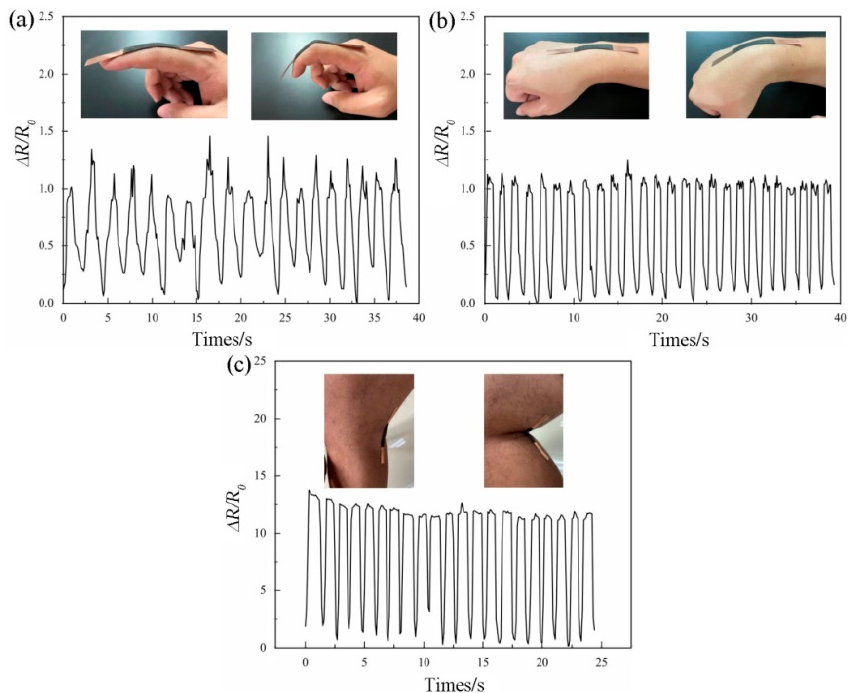
Figure 8. Monitoring of the motion of the human body with the functional flexible sensor. ( a ) Monitoring of the lateral flexion and extension of fingers, ( b ) monitoring of the lateral flexion of the wrist, ( c ) monitoring of the dorsal flexion and extension of the knee.